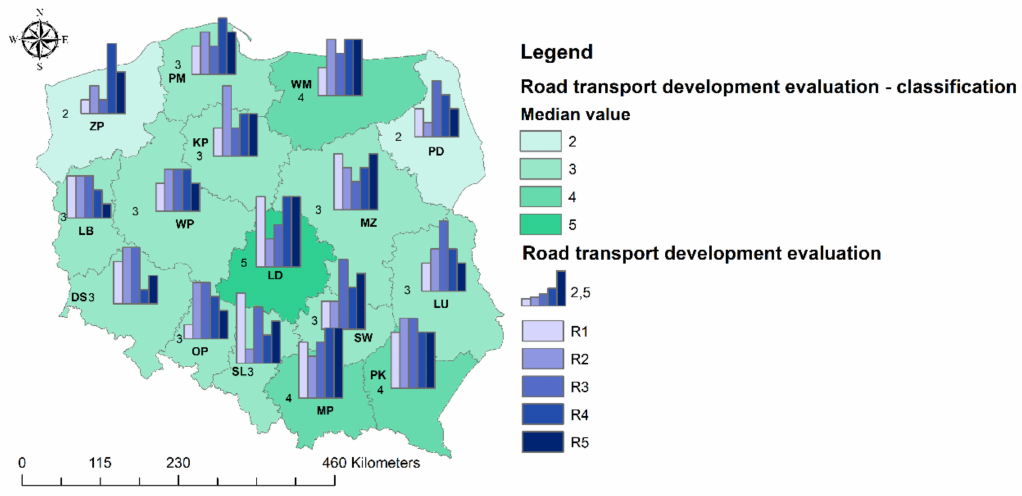
Figure 7. Road transport development evaluation—classification. Source: the authors.